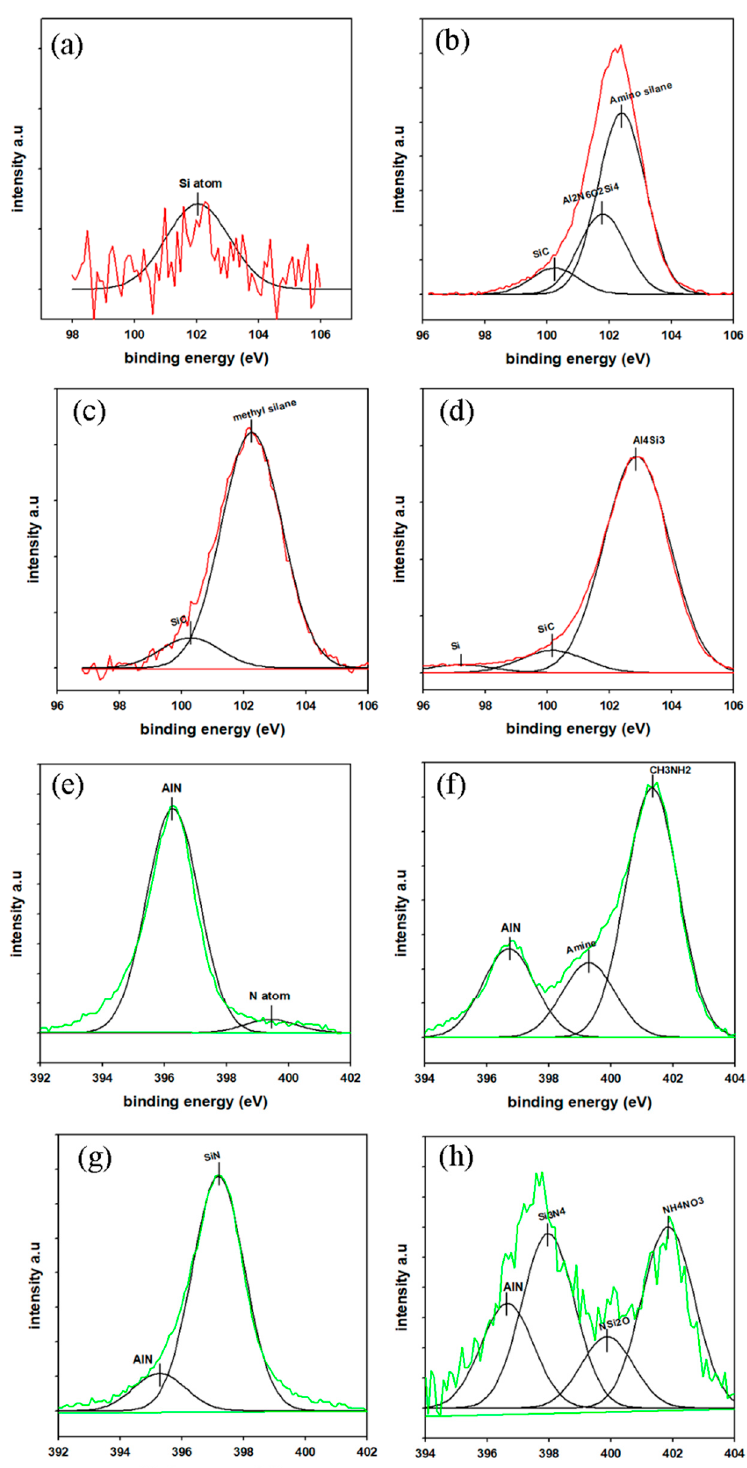
Figure 3. Si2p (top) and N1s (bottom) deconvoluted XPS spectrum of ( a , e ) raw AlN, ( b , f ) APTES-AlN, ( c , g ) VTES-AlN, and ( d , h ) PSZ-AlN.